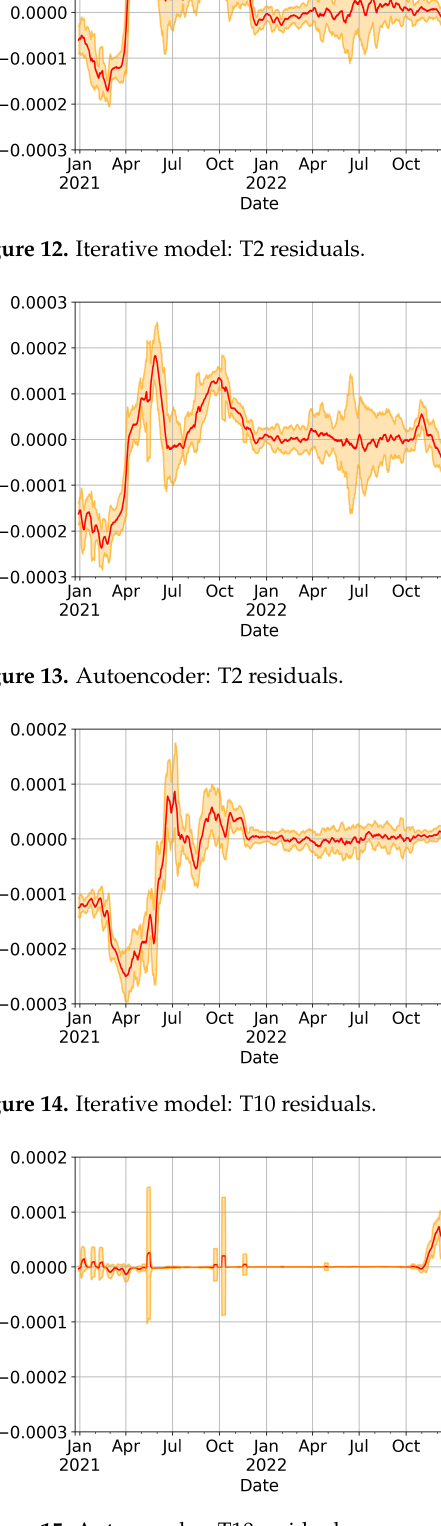
Figure 15. Autoencoder: T10